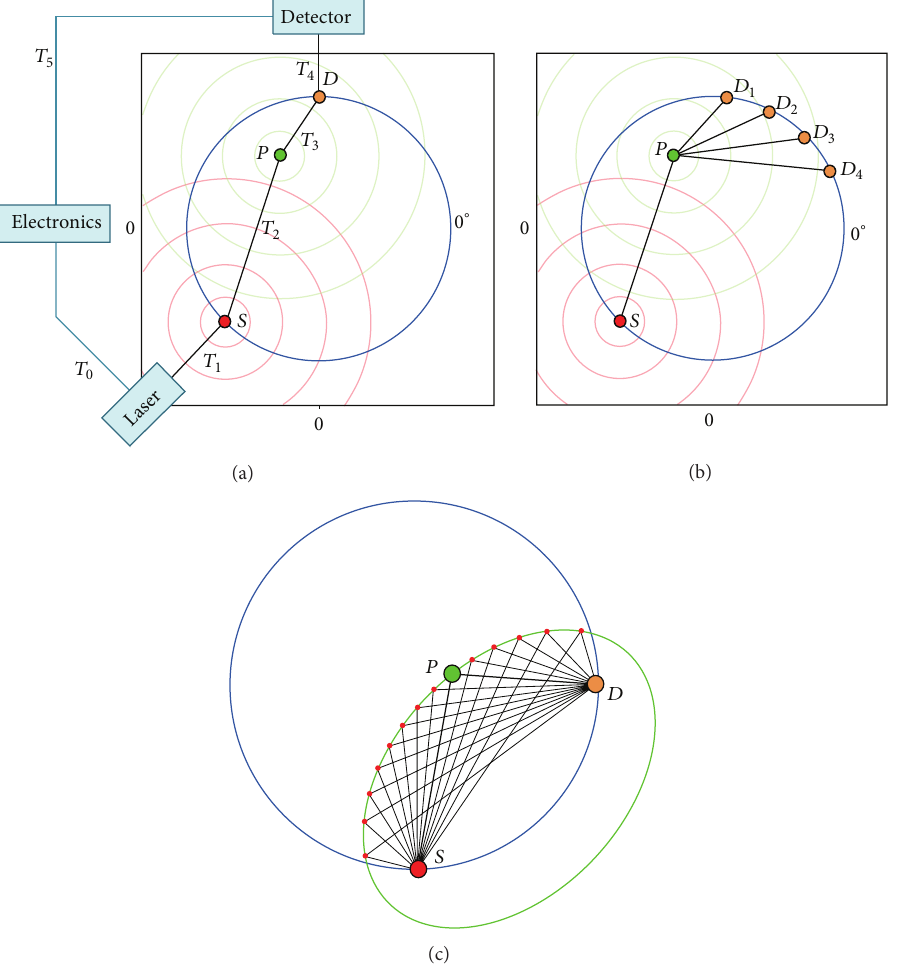
Figure 10: (a) Times and delays involved in an EPAT measurement for a given source-detector (SD) pair. (b) Several SD pair measurements for localizing an inclusion. (c) The result of a given SD pair measurement constrains the inclusion to lie on an oval.